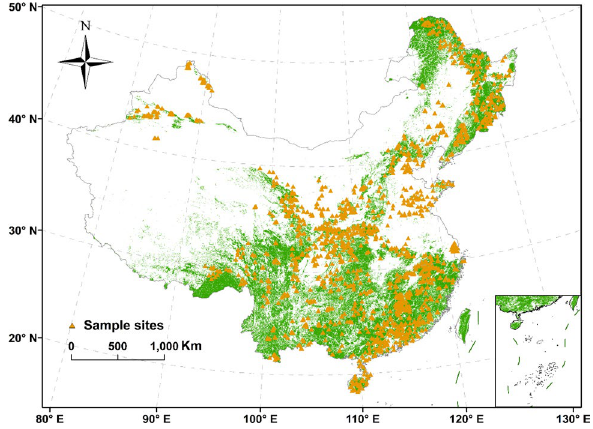
Figure 1. Distribution of sample sites in China. The dark yellow triangles indicate forest plots. (Map created using ArcGIS 10.6 software by first author, URL: